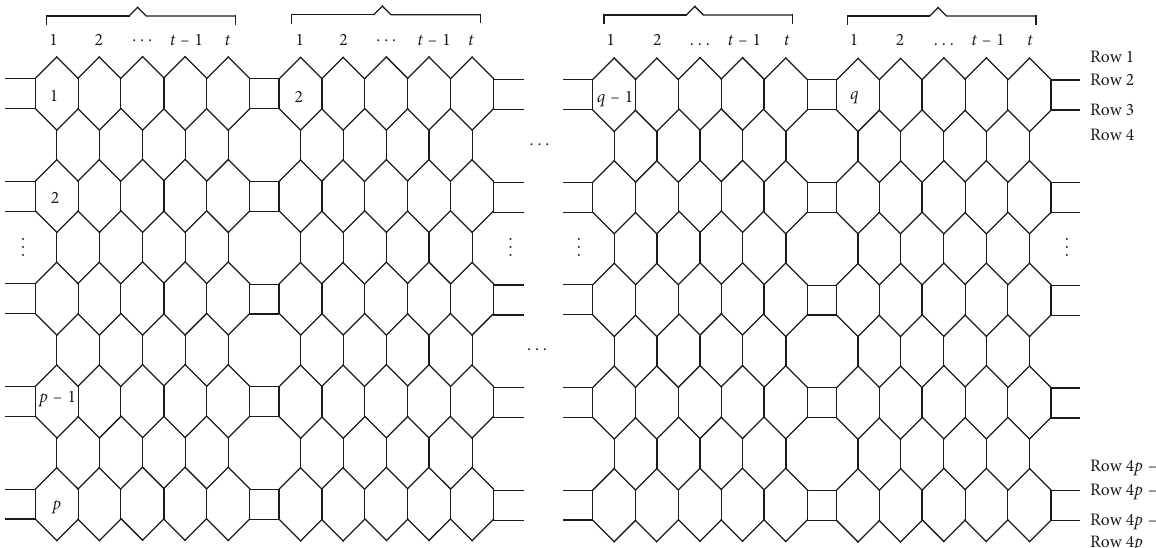
Figure 1: The polyacene molecules. (a) L1: Benzene; (b) L2: Naphthalene; (c) L3: Anthracene; (d) L4: Tetracene; (e) L5: Pentacene; (f) L6: Hexacene; (g) L7: Heptacene.